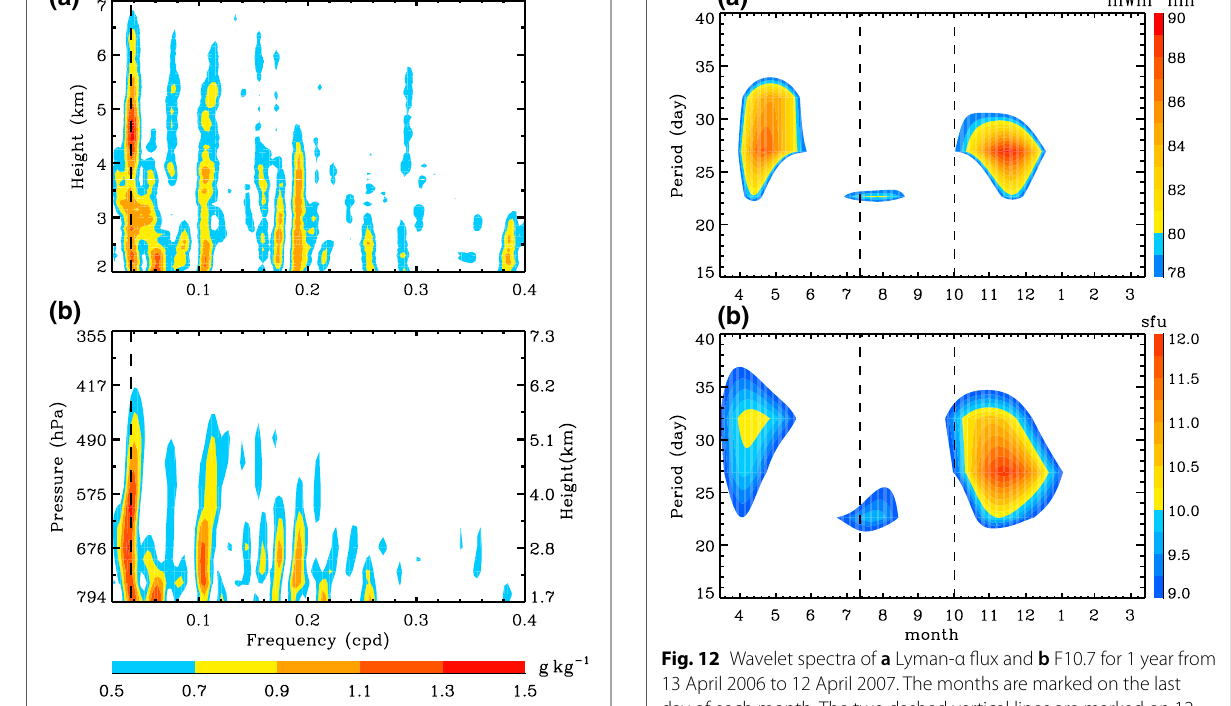
Fig. 11 Lomb–Scargle spectrum of specific humidity derived from a radiosonde observation and b reanalysis data over Pago Pago. The dashed vertical lines correspond to a period of 27 days